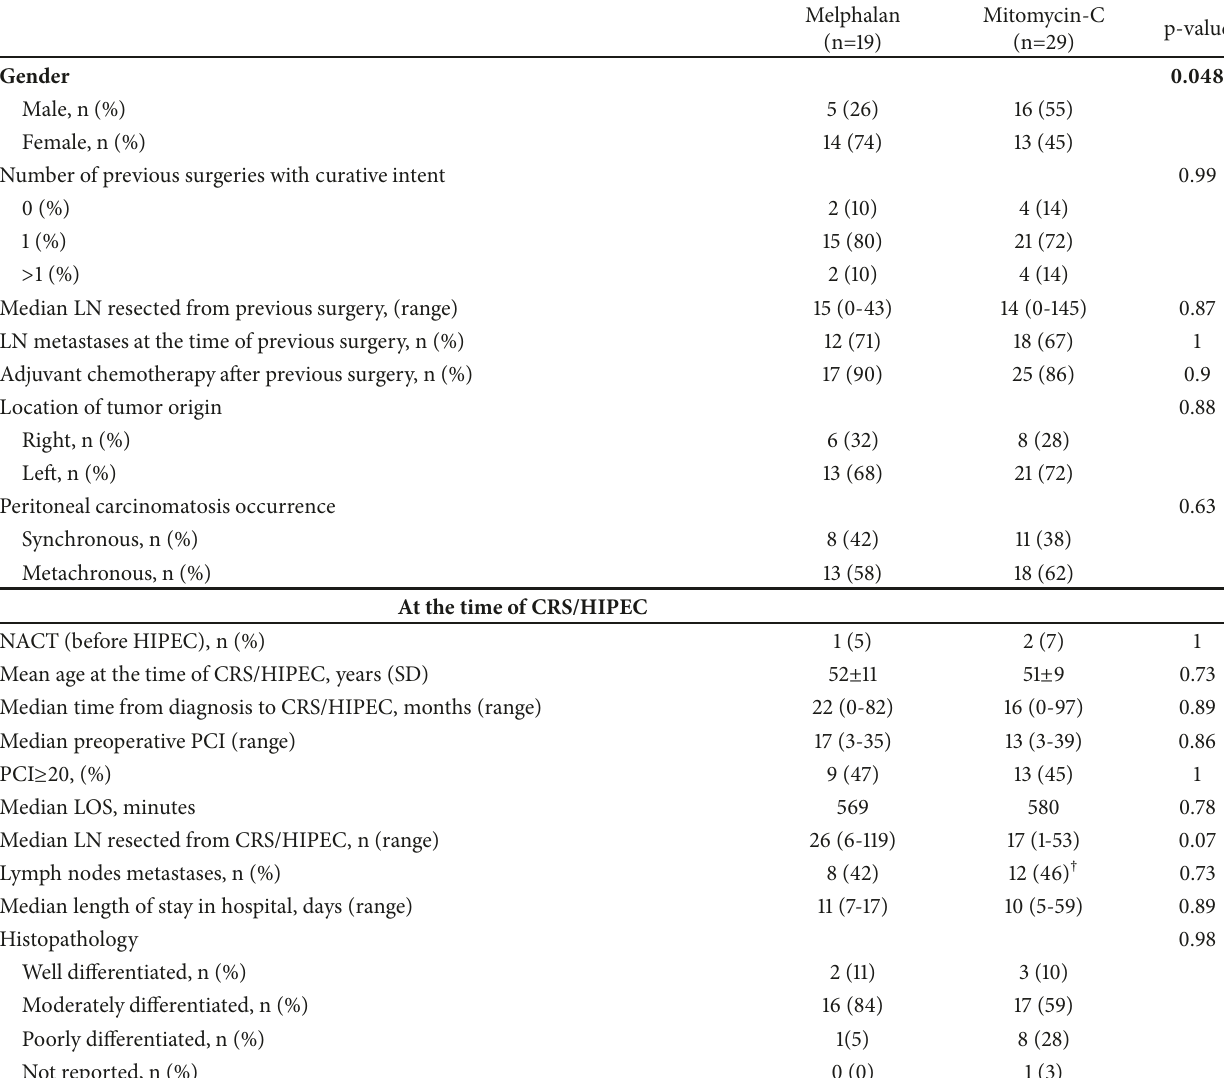
Table 1: Patient